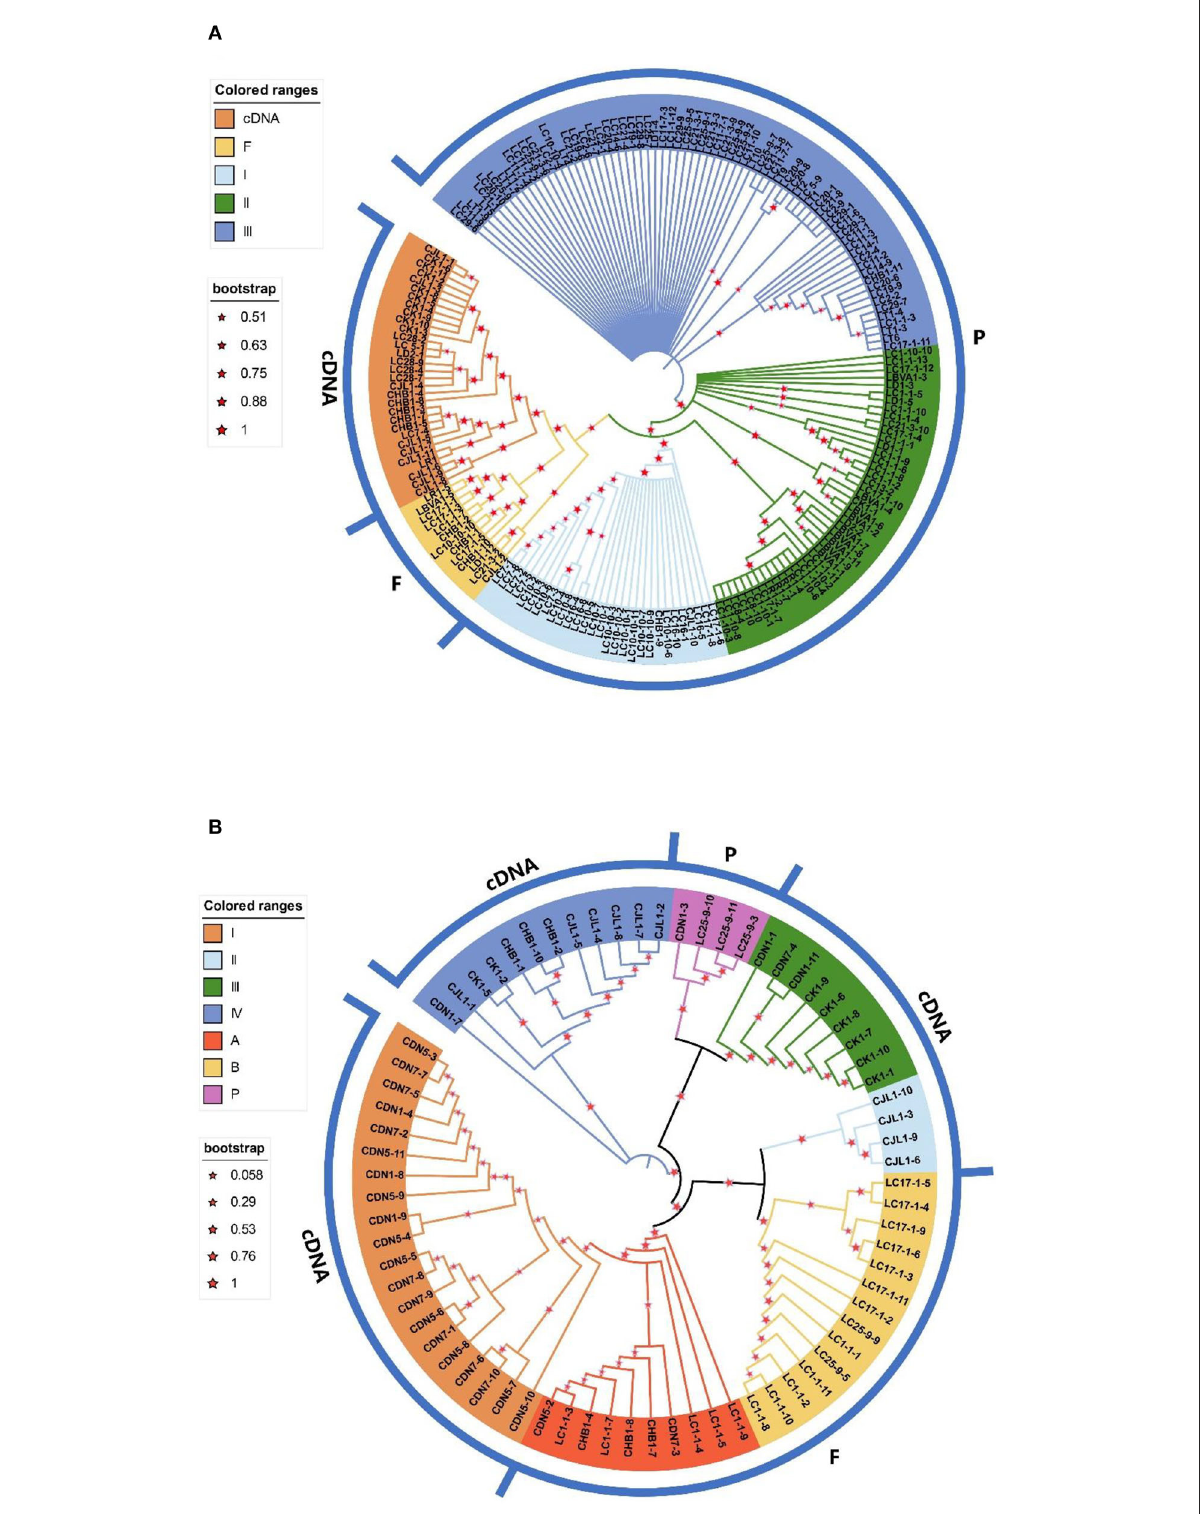
FIGURE3 Neighbor-joining trees constructed by using the P-distance matrix from the entire ITS region of all paralogues (1,000 bootstraps). (A) The phylogenetic tree constructed using all sequences from the primer pair ITS1/ITS4. (B) The phylogenetic tree constructed using all sequences from the primer pair P1/P2. F represents presumed functional ITS sequences, P represents putative ITS pseudogene sequences, and cDNA represents ITS cDNA sequence bootstrap values >